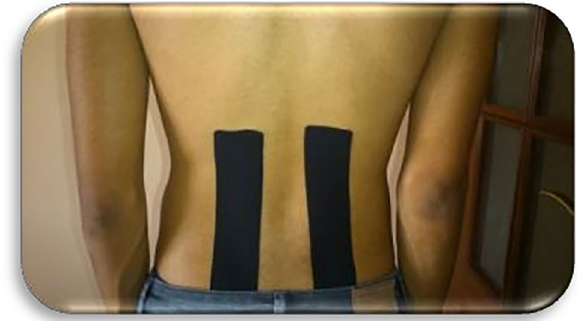
Figure 1. Paravertebral inhibition technique with kinesio